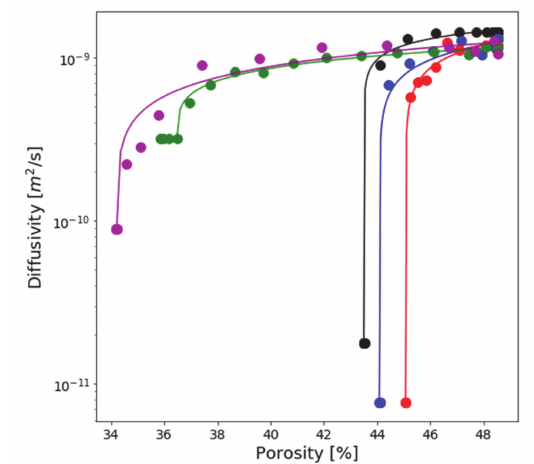
Figure 19. Pore-scale simulation results (data points) illustrating changes in the porosity-effective diffusivity relationship (fitted solid lines) as a result of mineral precipitation under different precipi- tation scenarios (black, blue and red are nucleation scenario with varied surface area and kinetic rate; green and magenta are the surface growth scenario with different kinetic